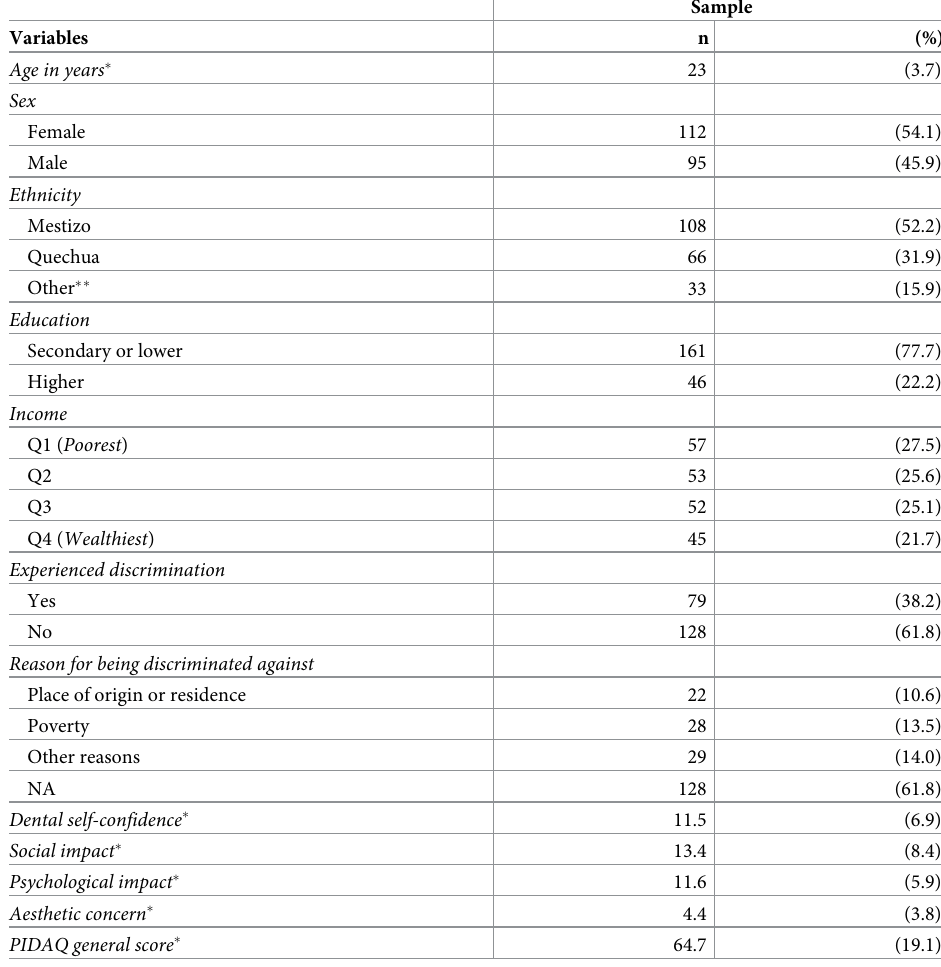
Table 1. Characteristics of 207 adult outpatients from a Peruvian public